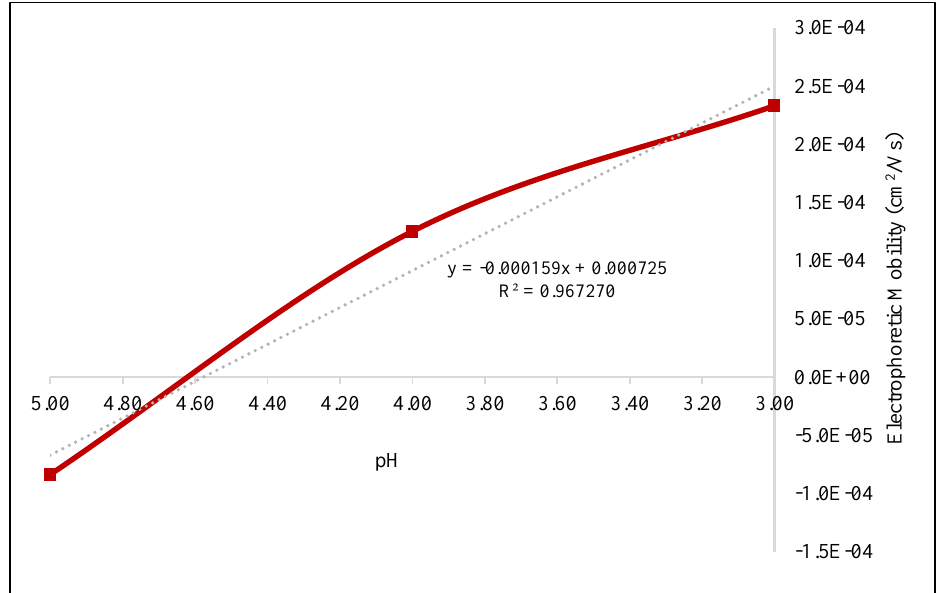
y = -0.000159x + 0.000725 R² =